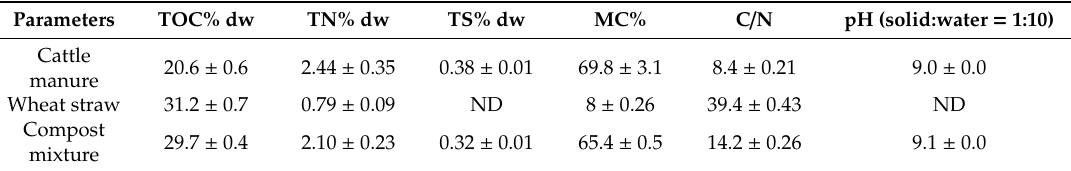
Table 1. Physical and chemical properties of raw materials and mixture (values are means ± SD, n = 3) a